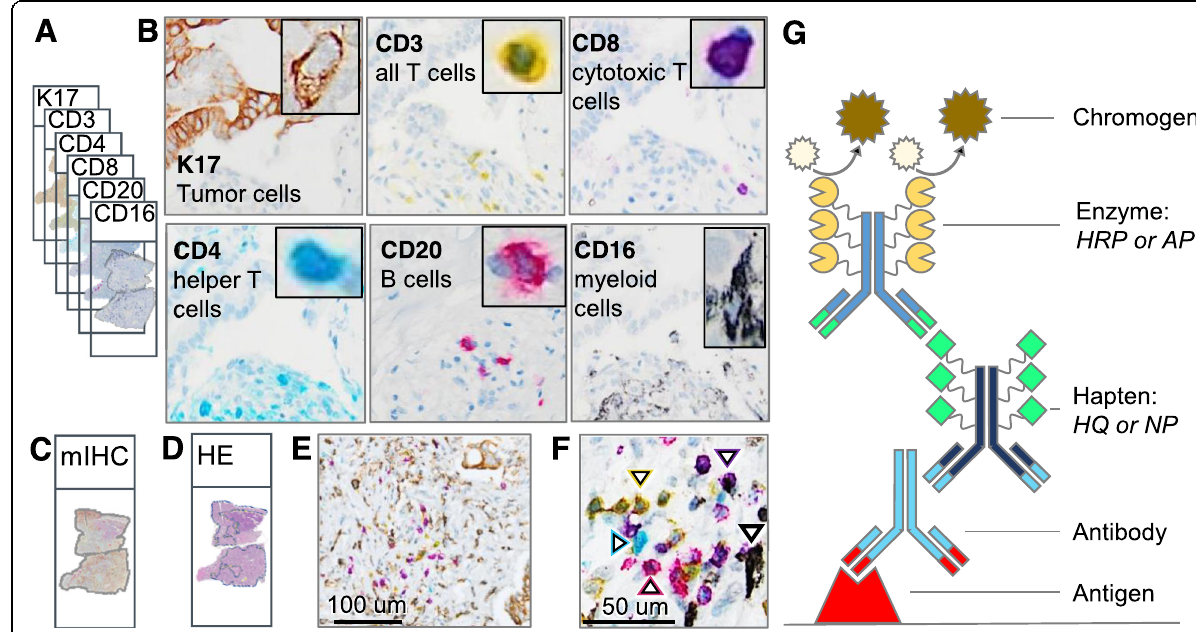
Fig. 1 IHC markers in the PDAC mIHC panel to study tumor immune interactions. A . Traditional IHC was used to stain six adjacent serial tissue sections with one biomarker per tissue section. Each biomarker is designated by a specific color. B . Representative images from single-marker IHC in serial tissue sections showing expression in the same region of interest (except for examples of sparsely distributed B-cells from a different area in the corresponding histologic section). Each inset shows the cellular expression of the corresponding marker at higher magnification. C . Multiplex IHC (mIHC) in adjacent serial section. D . Hematoxylin and eosin (H&E) in adjacent serial sections with delineation of the tumor region by a pathologist. E . mIHC with six IHC markers on a single tissue section with PDAC. F . At the highest magnification, each of the five immune cell classes are labeled with a white arrowhead outlined in the color corresponding to chromophore color. T-cell subtypes include CD3+ (yellow), CD4+ (teal), CD8+ (purple); B-cells denoted by CD20+ (red); and myeloid cells identified by CD16+ (silver-black). G . Indirect mIHC using hapten- conjugated secondary antibodies. Primary antibody binds to target antigen; secondary anti-mouse or anti-rabbit IgG antibody conjugated to synthetic haptens (HQ or NP) to bind primary antibody; and anti-hapten tertiary antibody conjugated to multiple enzyme molecules (e.g. horseradish peroxidase (HRP) or alkaline phosphatase (AP)) to bind secondary antibody. Chromogen substrate reacts with enzymes to generate insoluble unique color signal at the site of the targeted